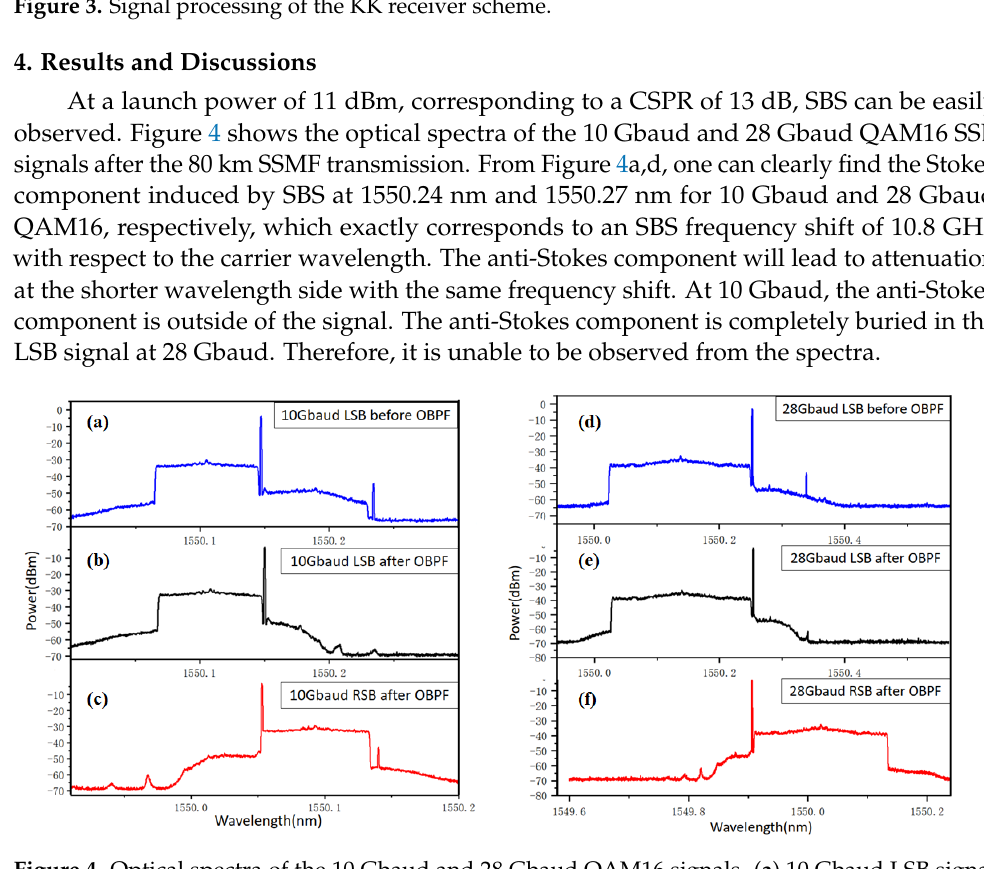
Figure 4. Optical spectra of the 10 Gbaud and 28 Gbaud QAM16 signals. ( a ) 10 Gbaud LSB signal before OBPF; ( b ) 10 Gbaud LSB signal after OBPF; ( c ) 10 Gbaud RSB signal after OBPF; ( d ) 28 Gbaud LSB signal before OBPF; ( e ) 28 Gbaud LSB signal after OBPF; ( f ) 28 Gbaud RSB signal after OBPF.